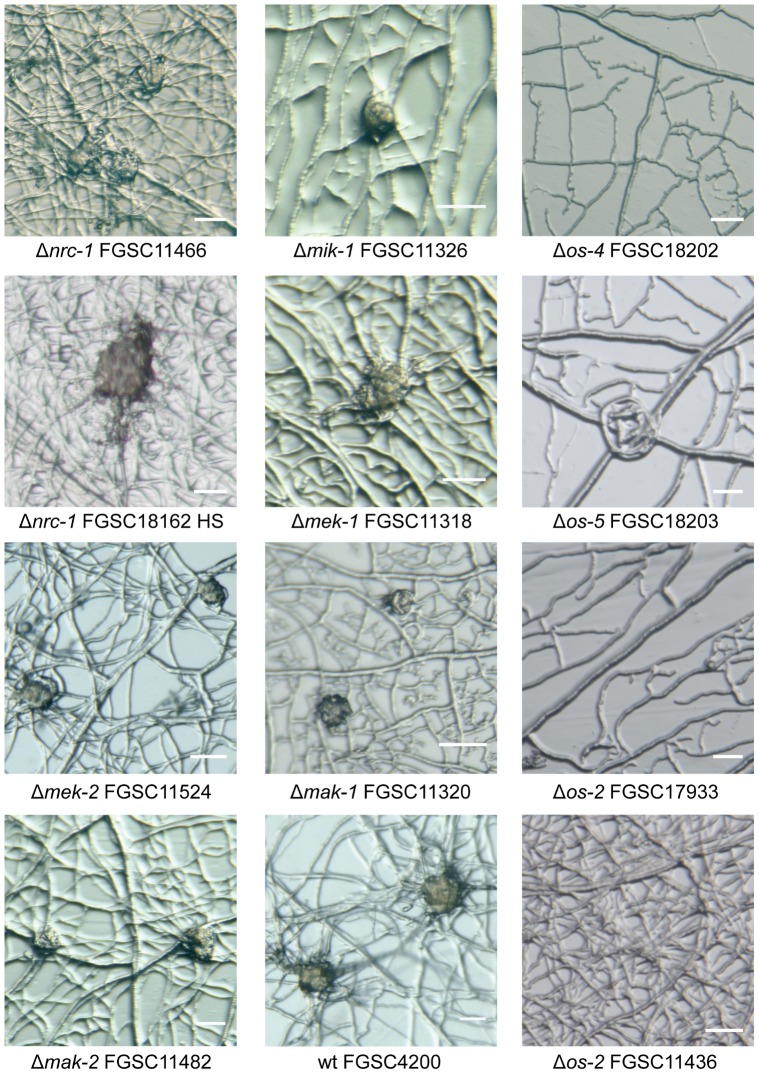
Protoperithecial development in MAP kinase gene-deletion mutants.In comparison to the wild type, which formed regular, subspherical protoperithecia 40–80 µm in diameter, only mutants of the PR- and CWI-MAP kinase cascades formed protoperithecial-like structures of similar appearance. These however, did vary in size, shape and degree of pigmentation and were not clearly discernable as protoperithecia even to an experienced microscopist using the stereomicroscopy technique shown here. It was these observations that warranted investigations using more powerful microscopic techniques, as used for Figures 1 and 6–8. Protoperithecial-like structures could not be observed in any of the newly generated OS-MAP kinase mutants. In contrast to the other os mutants, Δos-2 FGSC11436 showed disorganized mycelial architecture, typical of hyphal fusion defects. The Δnrc-1 strains generated from FGSC18162 by vegetative homokaryon selection (HS) showed no phenotypic differences compared to Δnrc-1 FGSC11466. In order to calibrate the results, all strains were inoculated onto cellophane over LSA medium (and SCM for comparison), and incubated for 5–7 days at 25°C dependent on the rate of developmental of the mutant strain. By cutting out cellophane squares carrying mycelium the same samples as shown here were subsequently prepared for LTSEM. Finally, these female cultures were fertilized with opposite mating type conidia of the wild type to confirm female sterility. All scale bars, 50 µm.